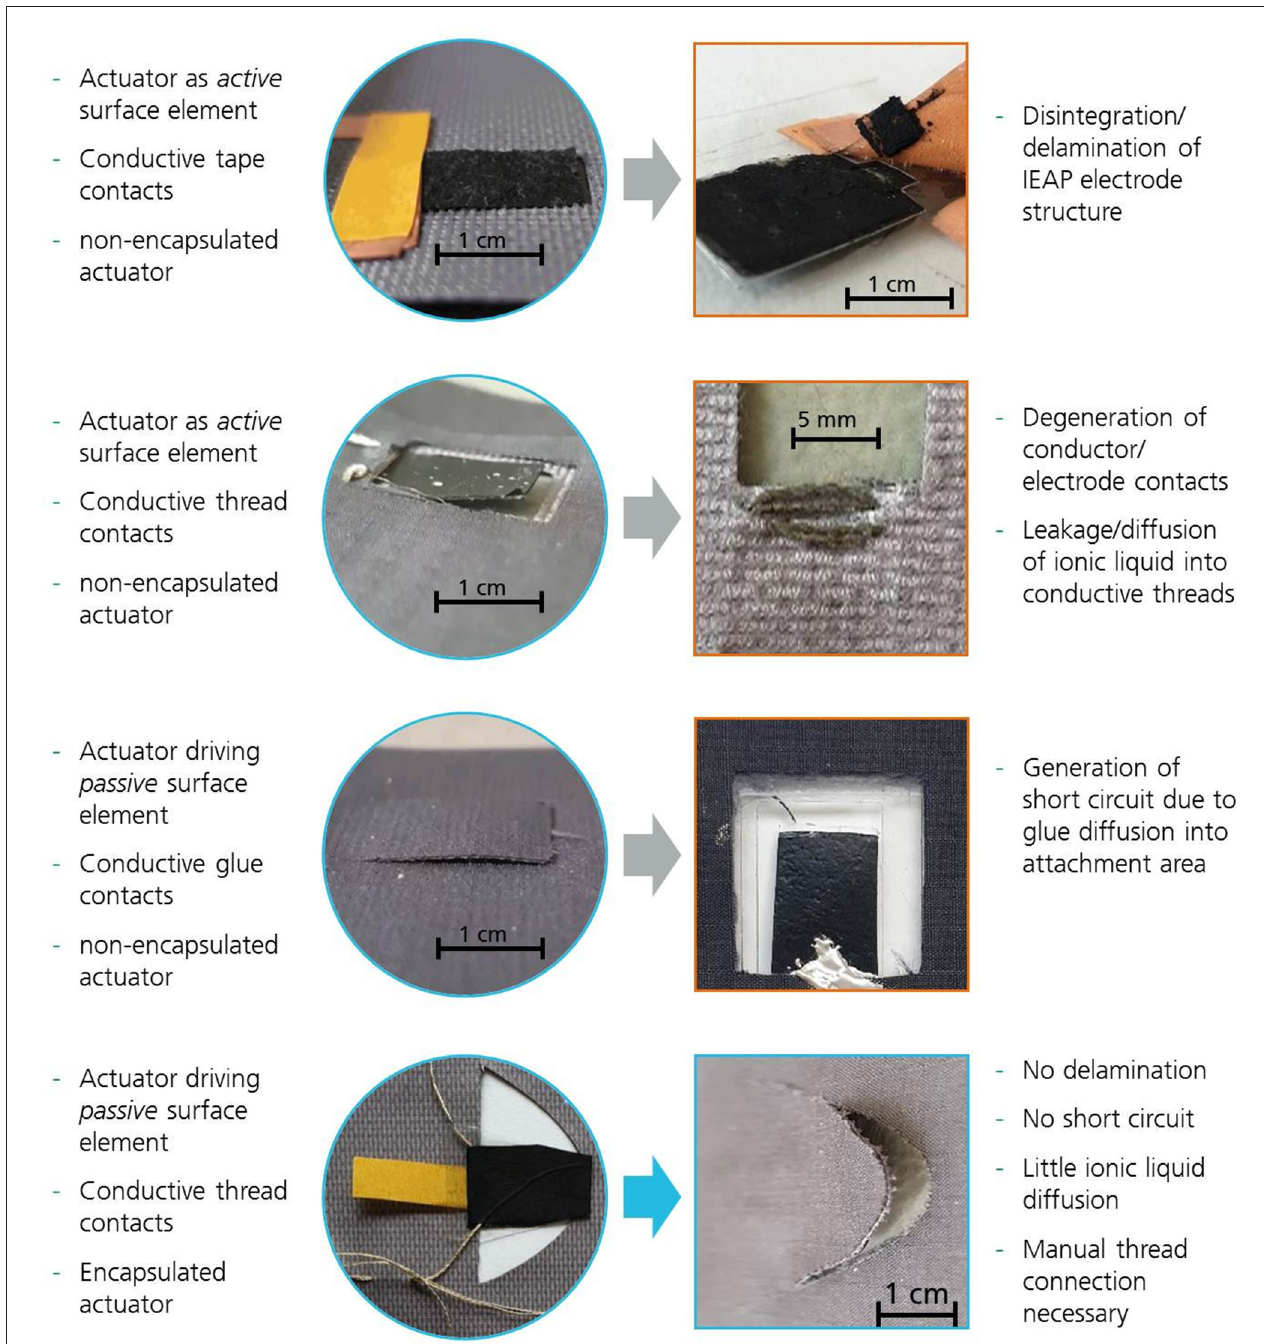
FIGURE 10 | Evolution of IEAP actuator/sensor integration challenges.